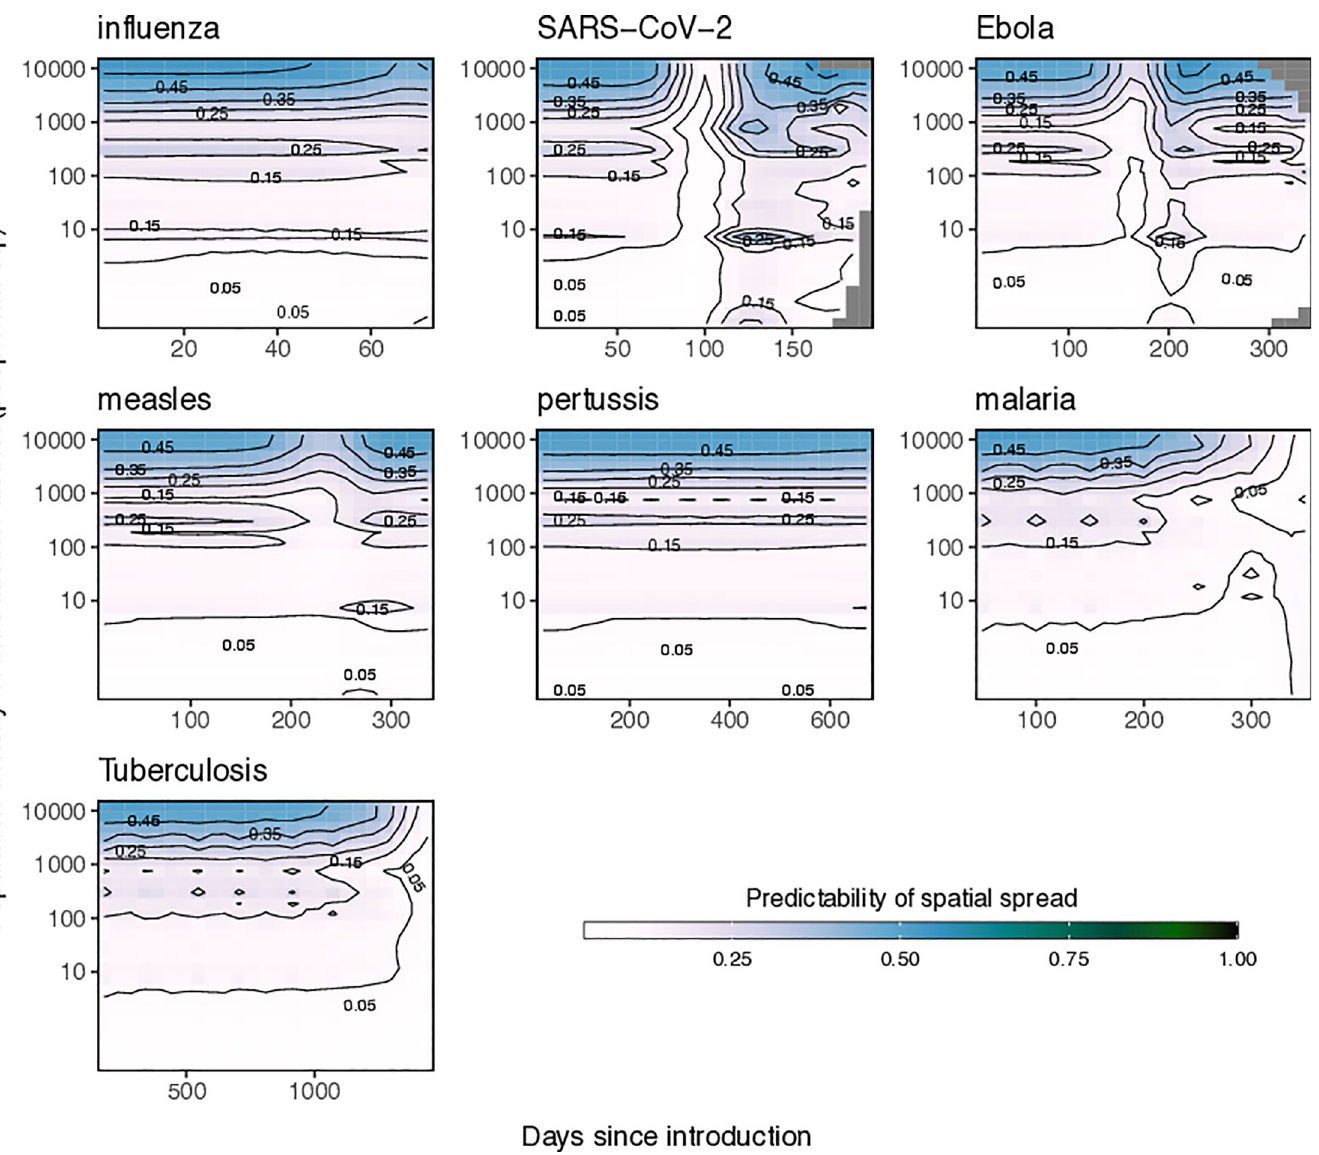
Fig 7. The change in spatial predictability for 6 pathogens plotted over time for outbreaks introduced to districts with a range of population densities. The results from simulations of outbreaks for 7 example pathogens (influenza, SARS-CoV-2, measles, Ebola, pertussis, P . falciparum malaria, and Tuberculosis). For each pathogen, outbreaks were introduced into each of the 105 districts in Namibia and the change in spatial predictability for successive generations was calculated. The heatmaps and contour lines show values of spatial predictability ( ϕ ) as they change over successive generations (x-axis) and the population density of the introduction district (y-axis). The number of days since the introduction is indicated on the top-axis. Annotations in the lower right indicate the pathogen, basic reproduction number (R 0 ), generation time in days ( γ ), and proportion of the population that is susceptible ( s ) used in spatial simulations. Transmission parameters used in simulations were drawn from the literature and shown in S1